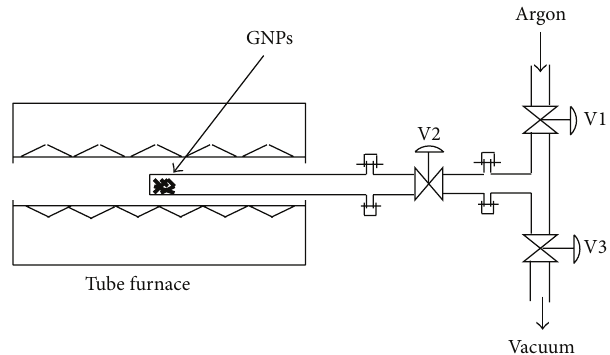
Figure 1: Direct vacuum annealing of GNPs.